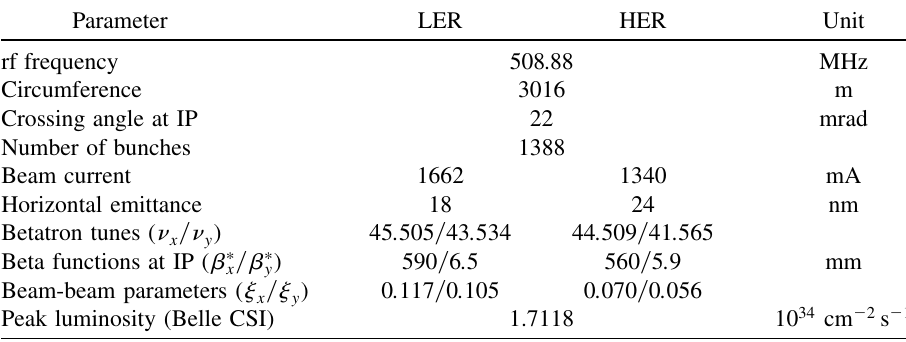
TABLE I. KEKB machine parameters on November 15,